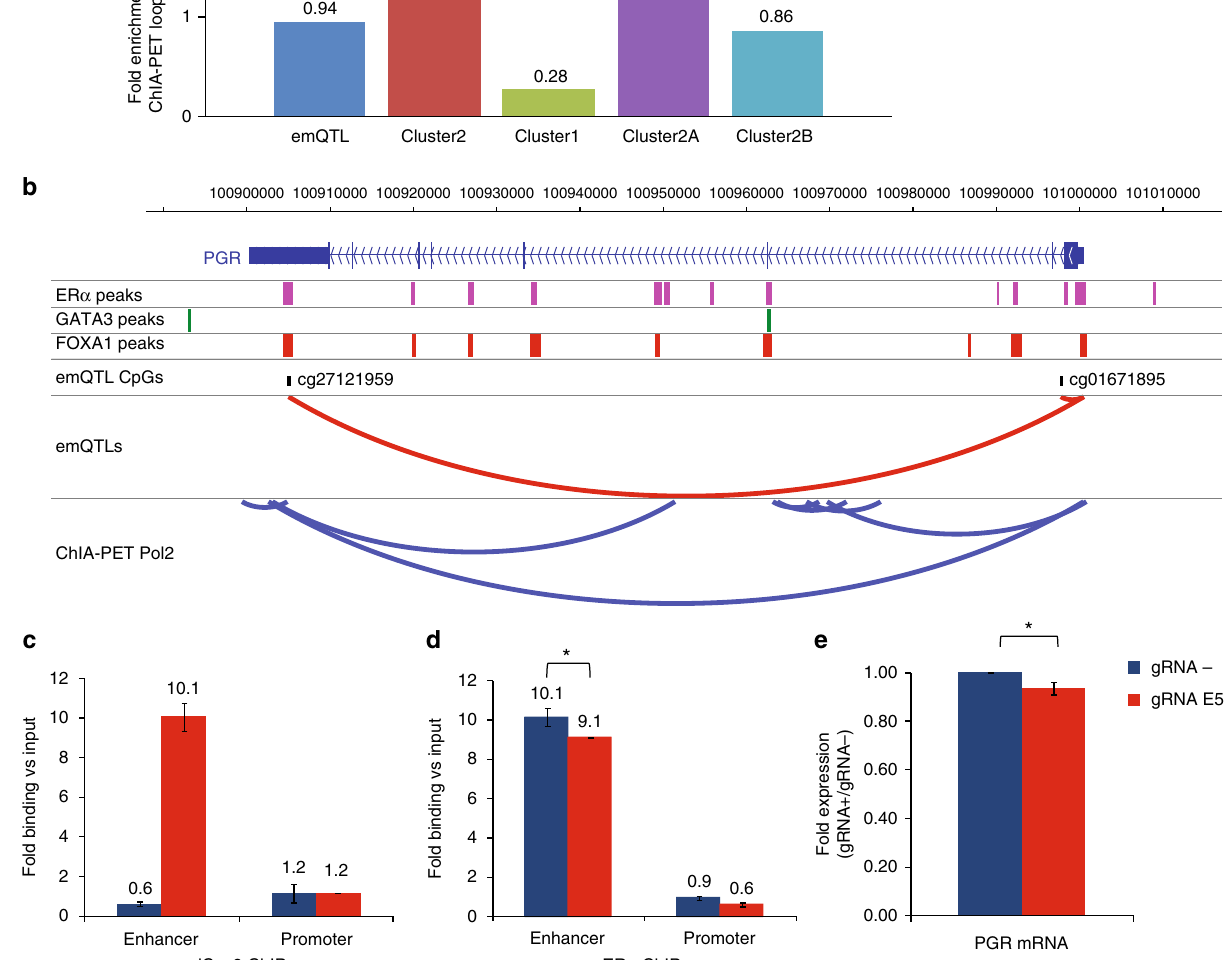
Fig. 6 Enhancer-promoter interaction and impact of TF binding on target gene expression. a Bar plot showing the enrichment of emQTL in ChIA-PET Pol2 loops for Cluster 1, Cluster 2, Cluster 2A and Cluster 2B. The height of the bars represents the level of enrichment measured as a ratio between the frequencies of emQTL (CpG – Gene pairs) found in the head and tail of Pol2 loops, over the expected frequency if such overlaps were to occur at random. Statistically signi fi cant enrichments (hypergeometric test, p -value < 0.05) are marked with an asterisk. b Example of overlap of emQTL ( red arcs ) and ChIA-PET Pol2 loops ( blue arcs ). Also shown are the location of ER α , FOXA1 and GATA3 binding regions. c , d dCas9 and ER α ChIP were performed in control ( − gRNA and dCas9) or transfected MCF7 cells (gRNA E5 and dCas9), to assess the binding of each protein at enhancer or promoter. Statistically signi fi cant differences ( t -test; two tails, p -value < 0.05) are marked with an asterisk. The data are presented as mean of three of independent replicates ± s.d. e mRNA levels of PGR were measured in control (-gRNA and dCas9) or transfected MCF7 cells (gRNA E5 and dCas9) by real-time PCR. Statistically signi fi cant differences ( t -test; two tails, p -value < 0.05) are marked with an asterisk. The data are the mean of three of independent replicates ±